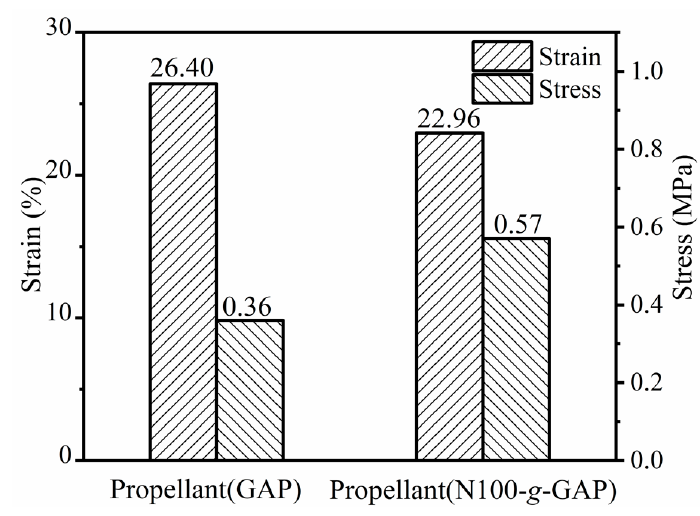
Figure 8. Stress–strain curves of the PTPET propellants prepared by N100- g -GAP and GAP ( Mn = 4000 g/mol) at 20 °C.